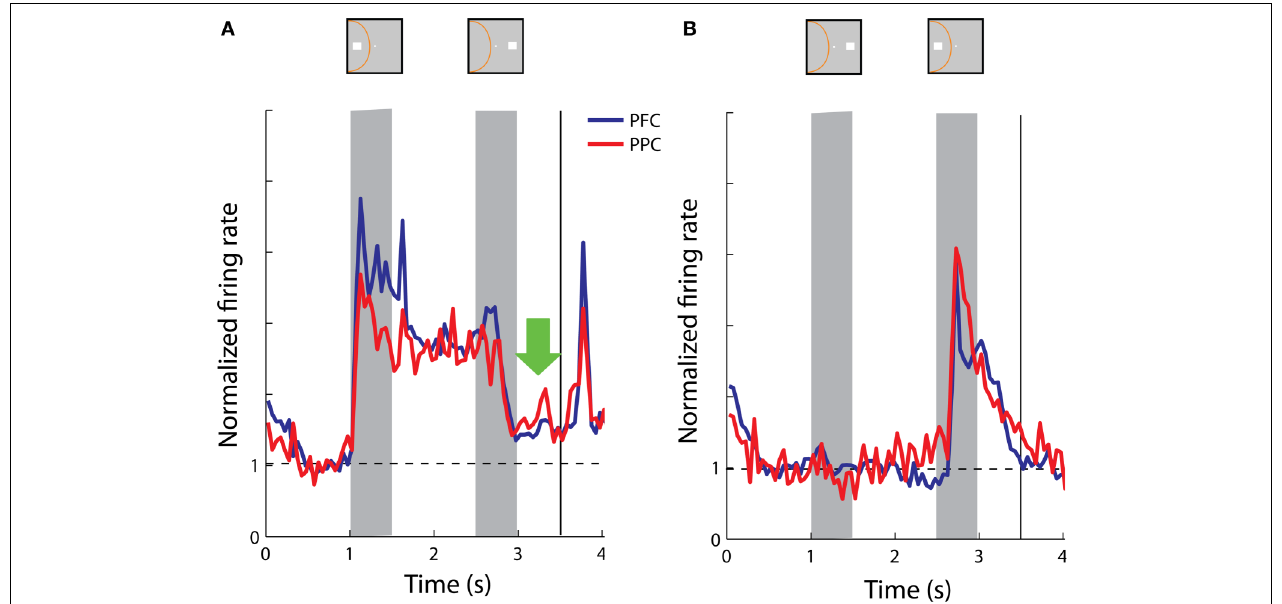
FIGURE 11 | Population responses from neurons with sustained activity recorded in the prefrontal ( N = 38) and posterior parietal cortex ( N = 17). Green arrow represents the delay period following a nonmatch stimulus out of the receptive fi eld. Data are shown from the Delayed Match-to-Sample task. (A) Average, normalized responses to the cue presentation in the receptive fi eld followed by a nonmatch stimulus out of the receptive fi eld. (B) Average responses to the cue presentation out of the receptive fi eld, followed by a nonmatch stimulus in the receptive fi